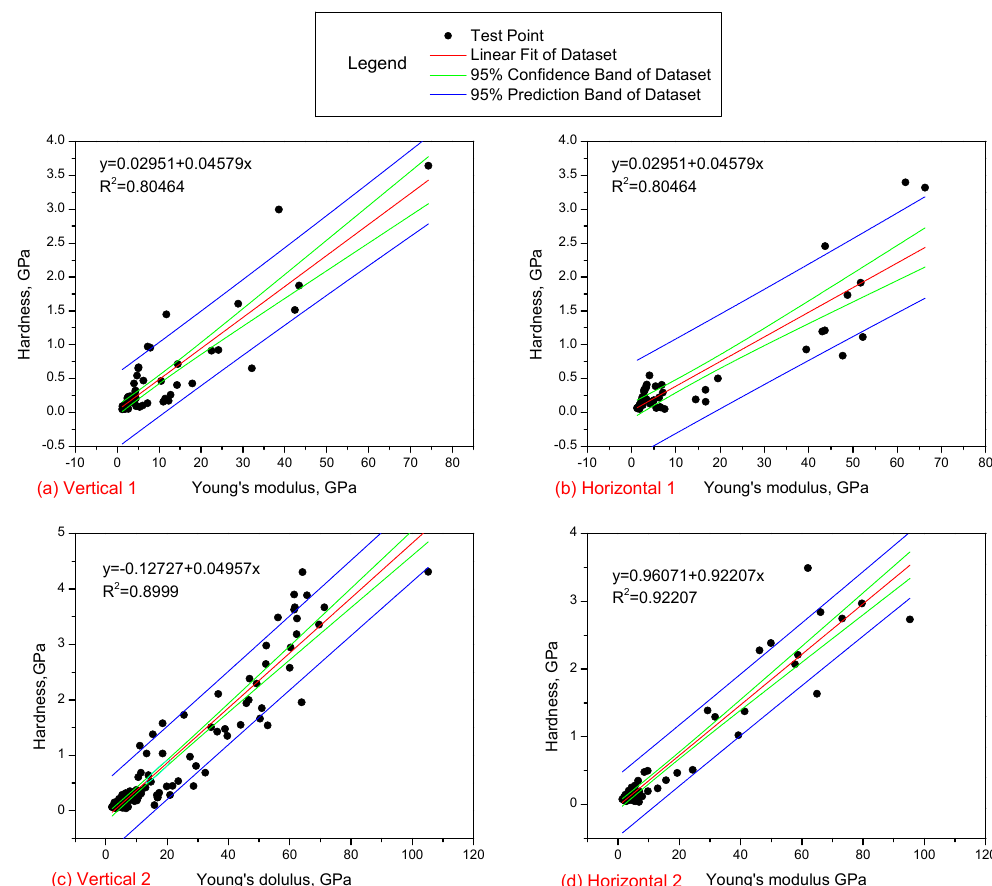
Figure 5. Relationship between Young’s modulus and hardness of four samples.